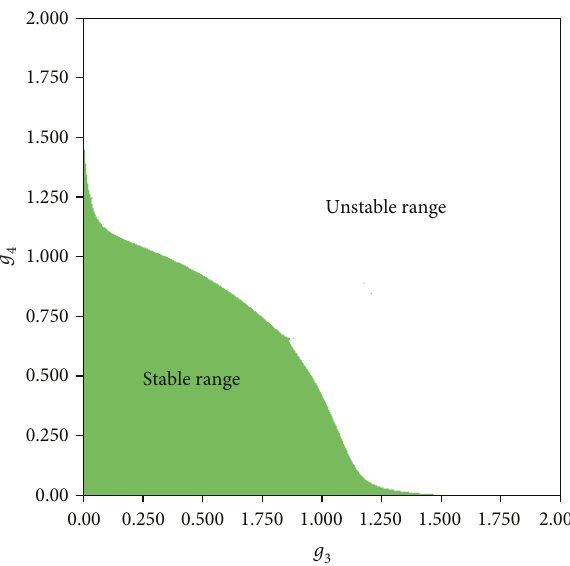
Figure 5: 2D bifurcation diagram of g